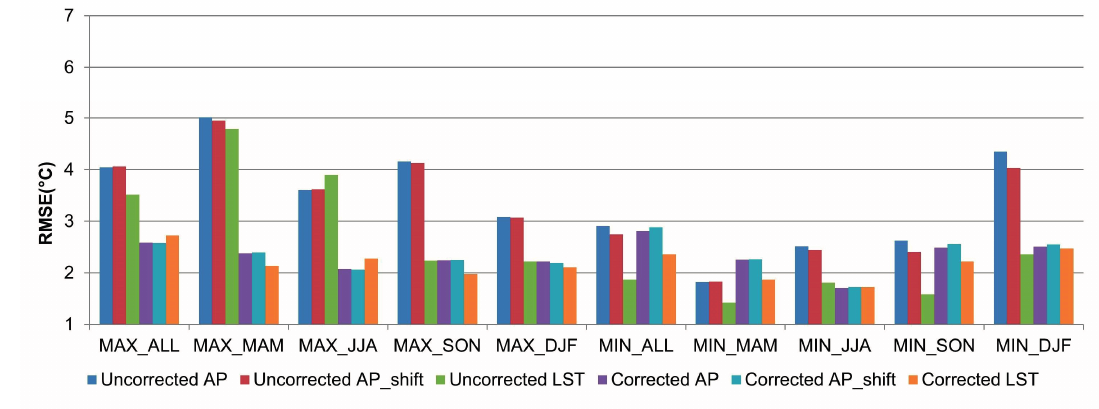
Figure 6. RMSE values averaged for 60 ASOS weather stations’ locations for estimating monthly air temperature with or without the correction using the CRU data (unit: °C).